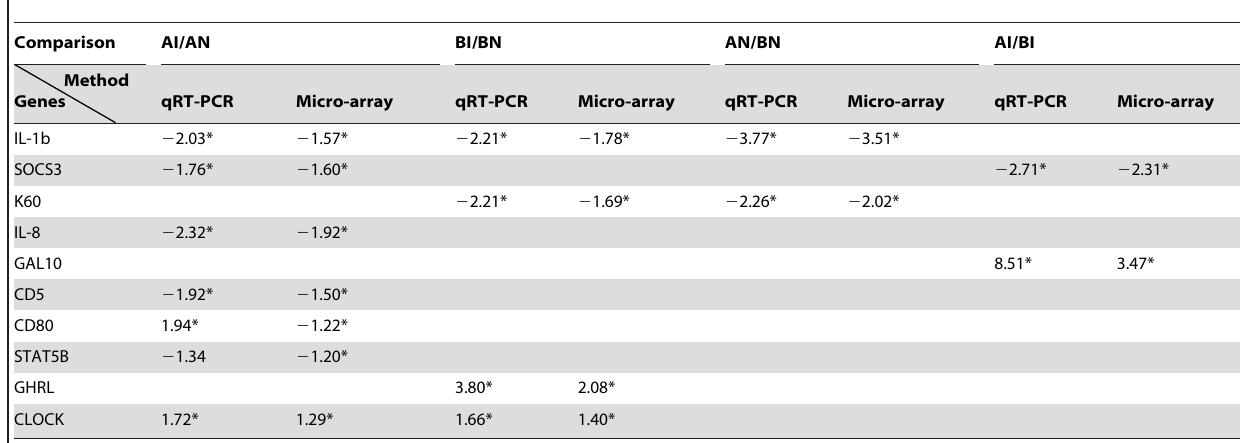
Table 3. Comparison of gene expression levels between microarray and qRT-PCR.